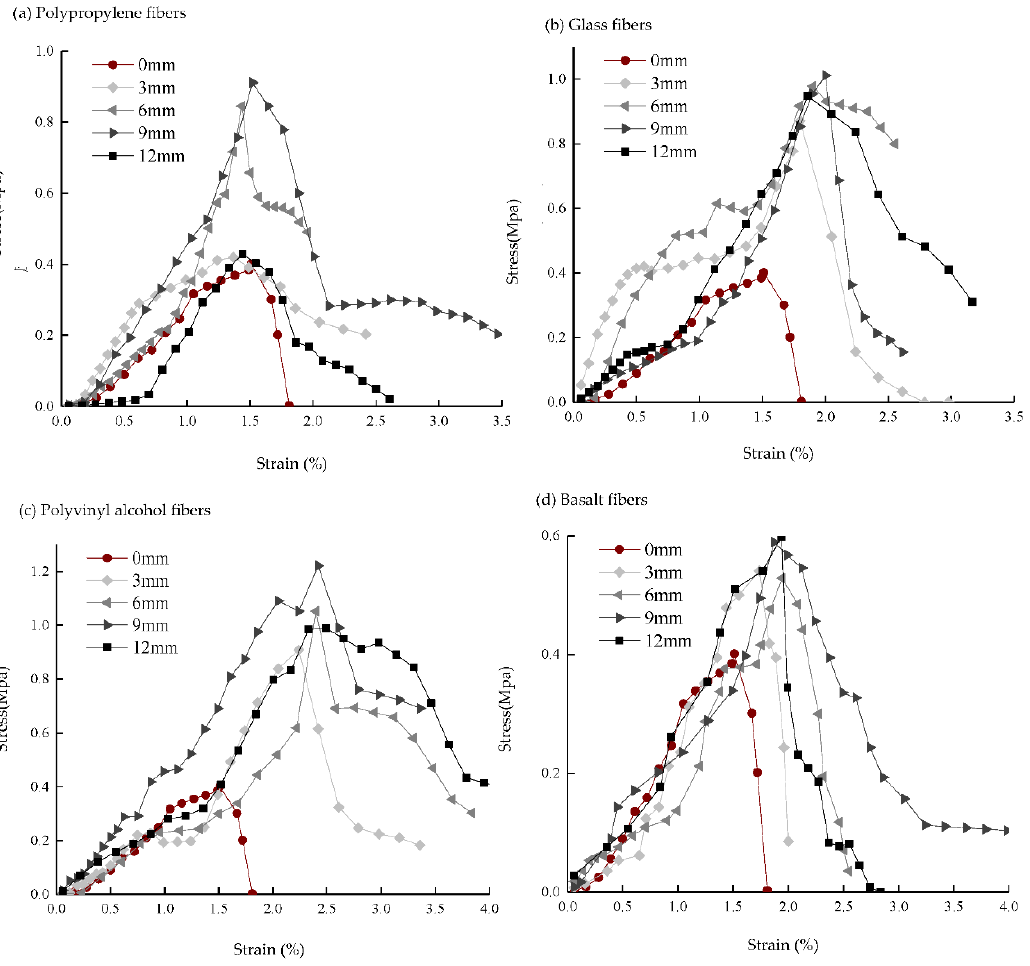
Figure 5. Stress–strain curve. ( a ) Polypropylene fibers; ( b ) Glass fibers; ( c ) Polyvinyl alcohol fibers; ( d ) Basalt fiber.